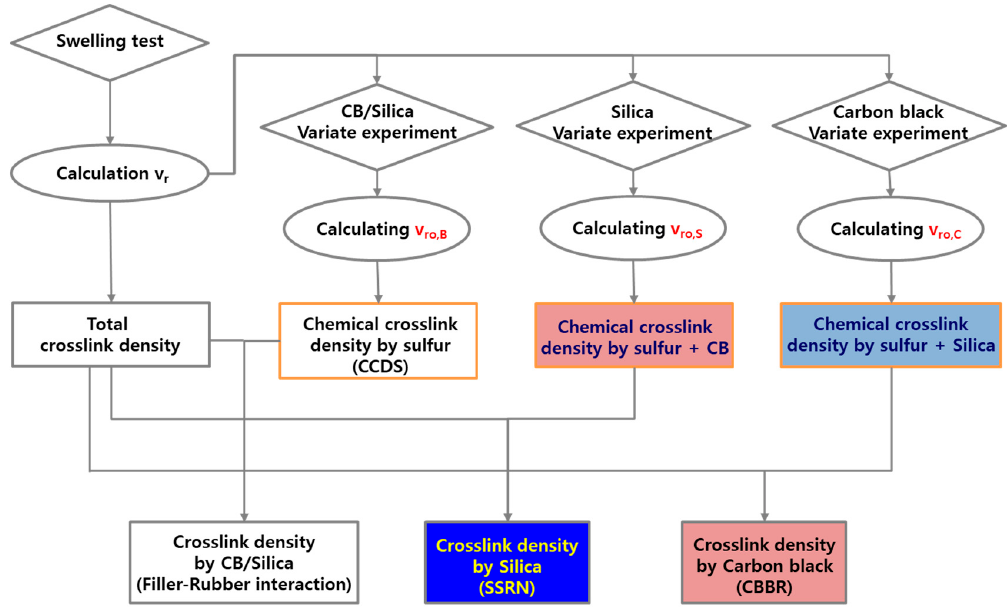
Figure 2. Flowchart of the analysis on vulcanizate structures using the swelling test and Flory–Rehner equation.